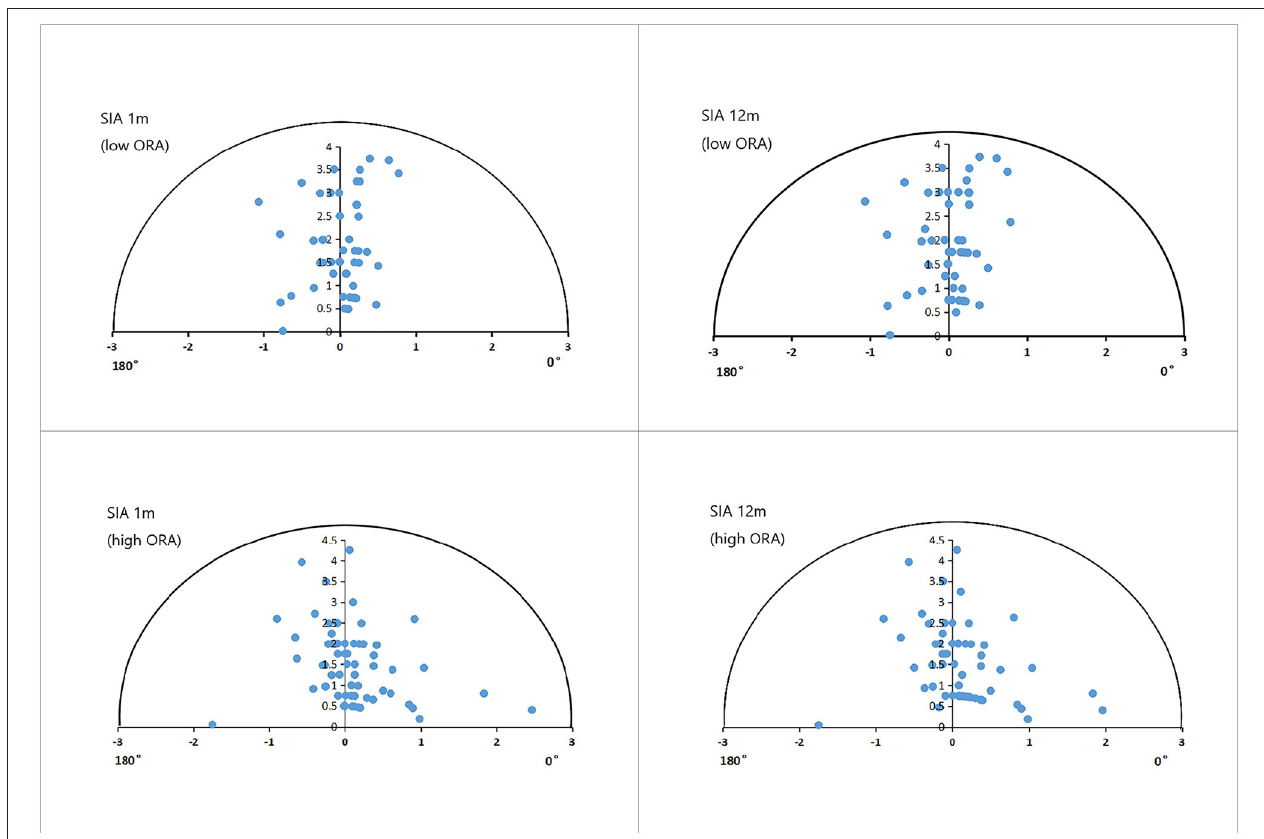
FIGURE 3 | Single-angle polar plots of refractive SIA in the low- and high-ORA groups. ORA, ocular residual astigmatism; SIA, surgical-induced astigmatism.